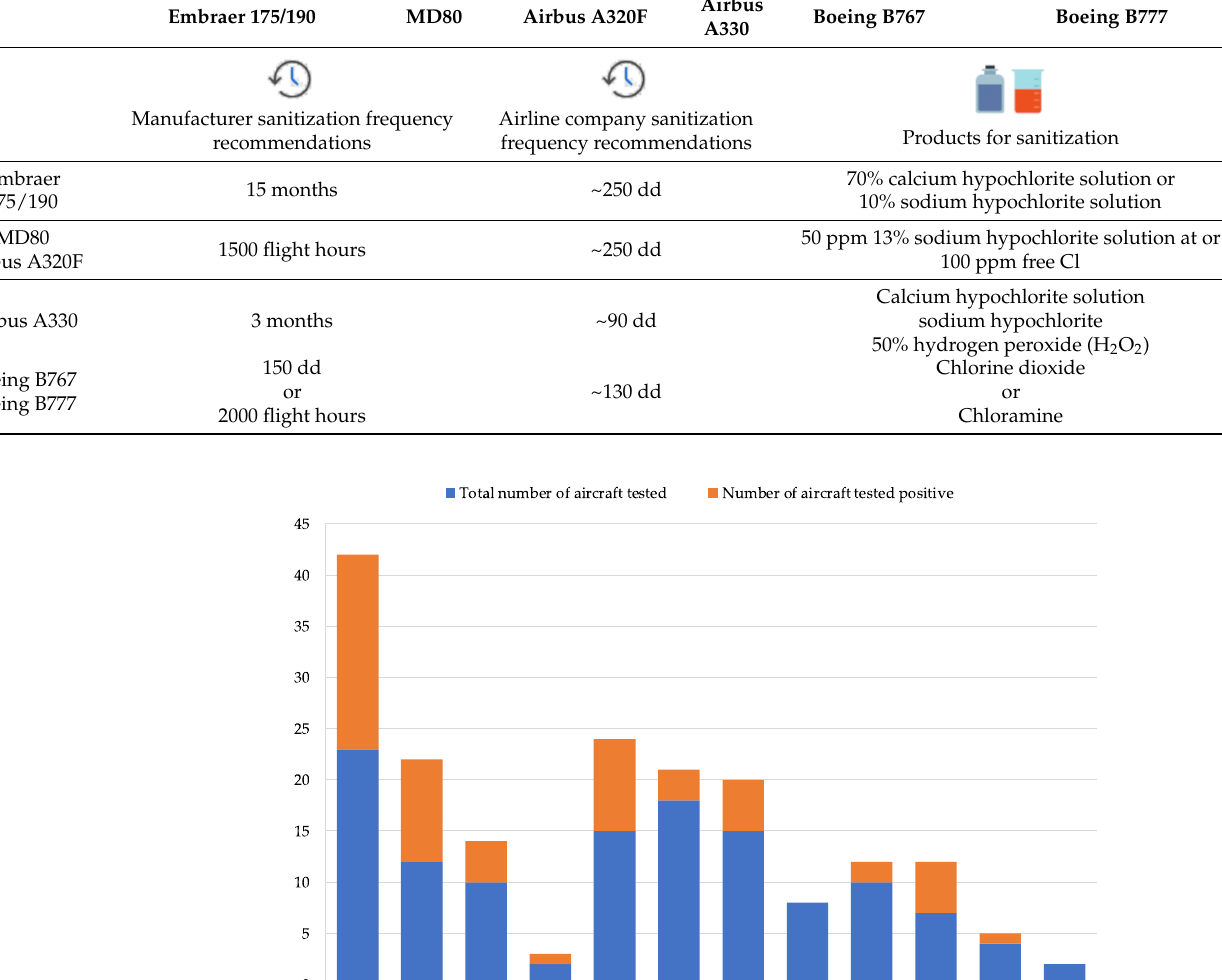
Table 2. Number of samples per type of aircraft and related